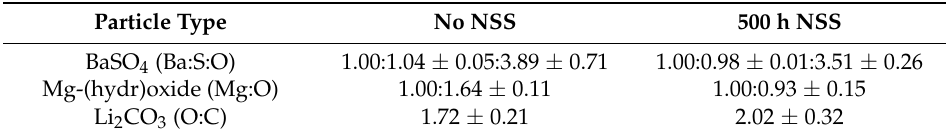
Table 3. Composition (at %) from EDS analysis of inorganic particles in the primer. Each datum is an average of five determination on large particles. (Data overaged over four analyses).